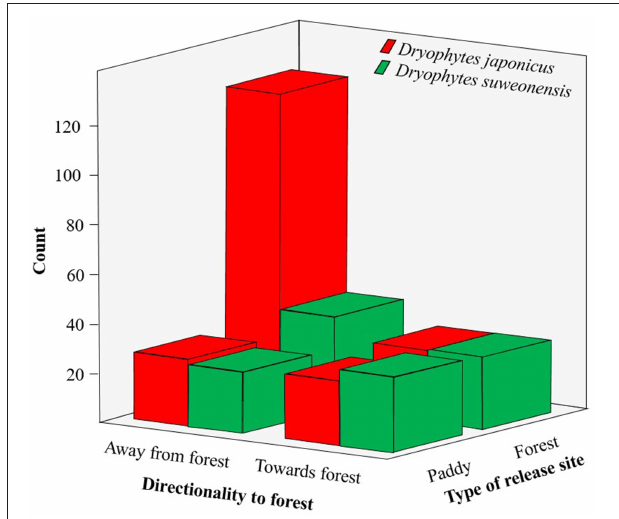
FIGURE 7 | Differences in the directionality of displacements shown by Dryophytes suweonensis and D. japonicus in relation to the type of sites where they were released and the directionality to forests. The only significant difference is between D. japonicus movement away from the forest, when released in the forest